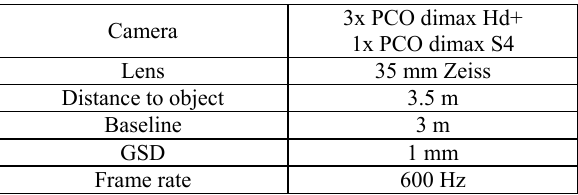
Table 1 . Properties of the photogrammetric